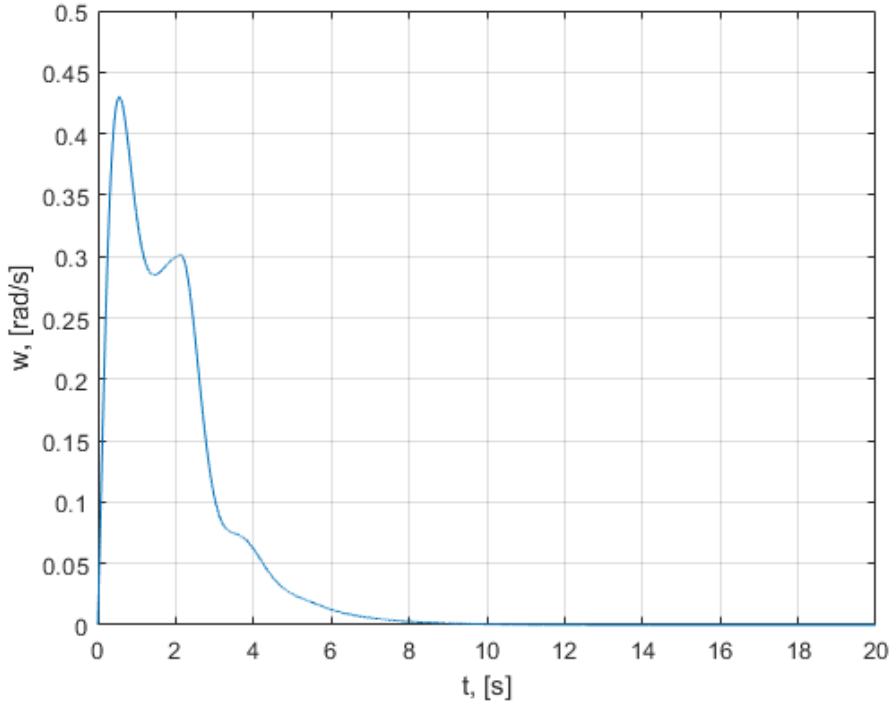
Figure A7. The speed response of position control system.